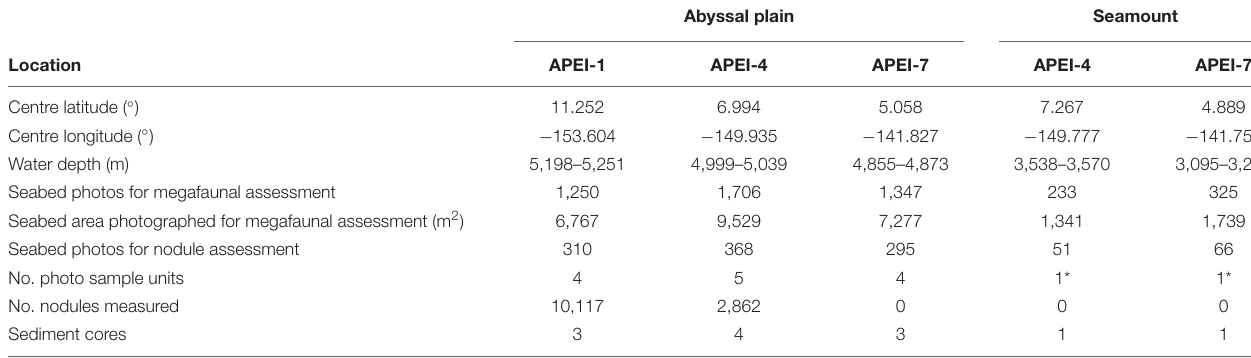
TABLE 1 | Sediment coring and photographic transect information for the study sites in the western CCZ. Four sample units were created of 73 photos for nodule coverage and 312 photos for megafauna on the abyssal plain; on the seamounts, those sample unit sizes could not be achieved (indicated by *). Abyssal